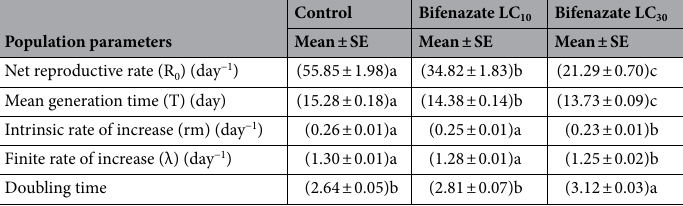
Table 3. The sublethal effects of bifenazate on Panonychus citri population parameters. Means in a row followed by the same letter are not significantly different by the boostrap paired test ( p >